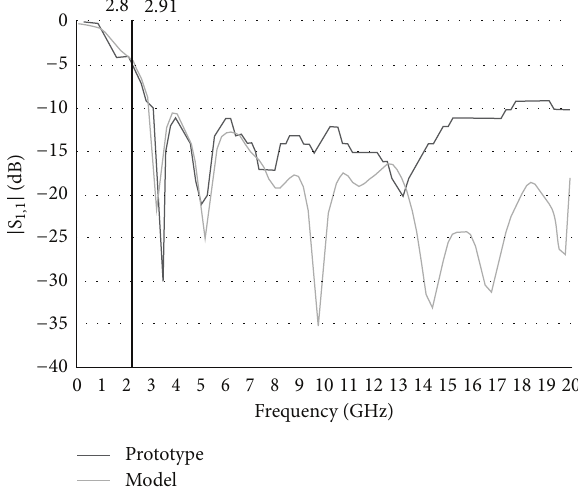
Figure 27: Simulated and measured reflection coefficient magni- tude of the proposed planar directional UWB antenna for a lower cutoff frequency of 3